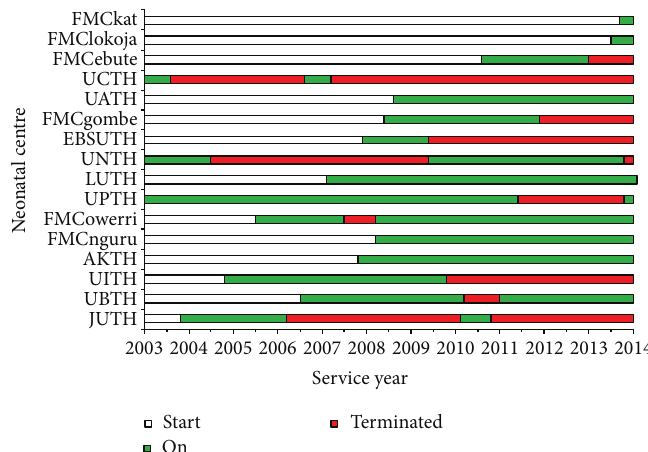
Figure 7: Failure-preventive audit culture (FAC) agreement timeline for the 16 tertiary hospitals that ever embarked on this up to the end of 2013. Neonatal centres were located at various Nigerian cities: FMCkat (city of Katsina), FMClokoja (Lokoja), FMCebute (EbuteMetta Lagos), UCTH (Calabar), UATH (Gwagwalada Abuja), FMCgombe (Gombe), EBSUTH (Abakaliki), UNTH (Enugu), LUTH (Idi-Araba Lagos), UPTH (Port Harcourt), FMCowerri (Owerri), FMCnguru (Nguru), AKTH (Kano), UITH (Ilorin), UBTH (Benin-city), and JUTH